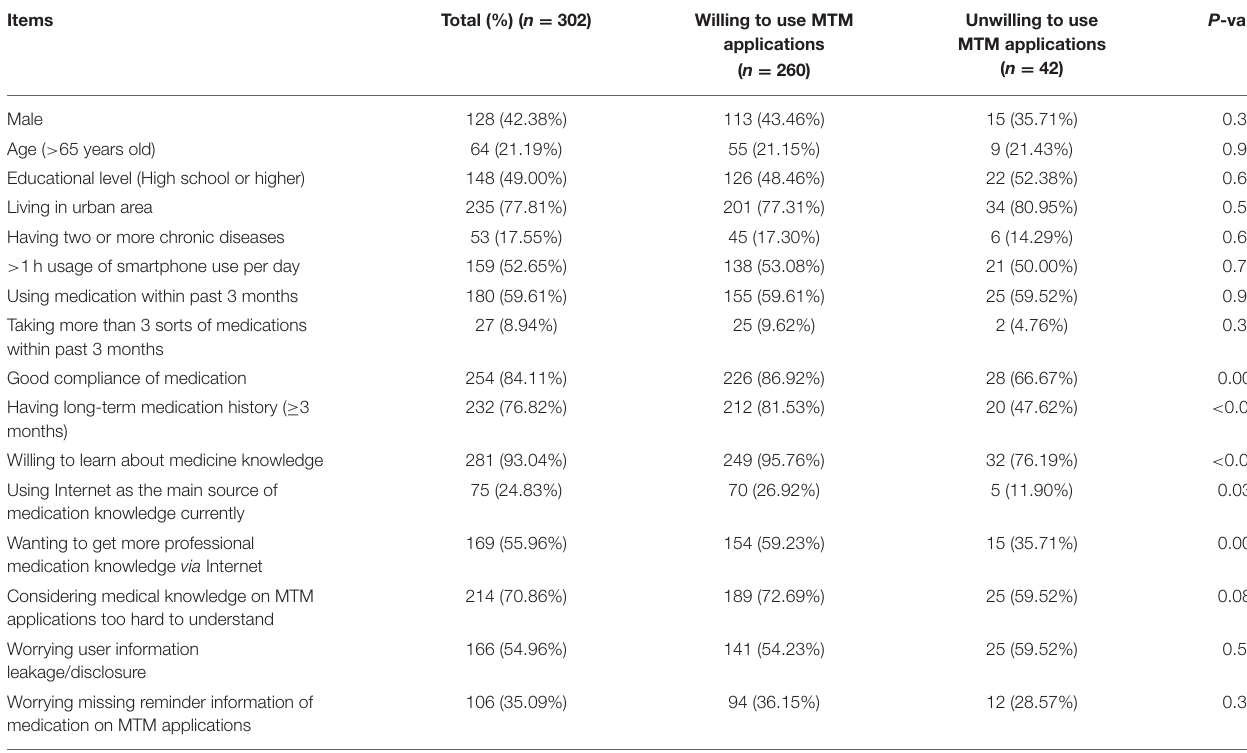
TABLE 2 | General demographic characteristics of the